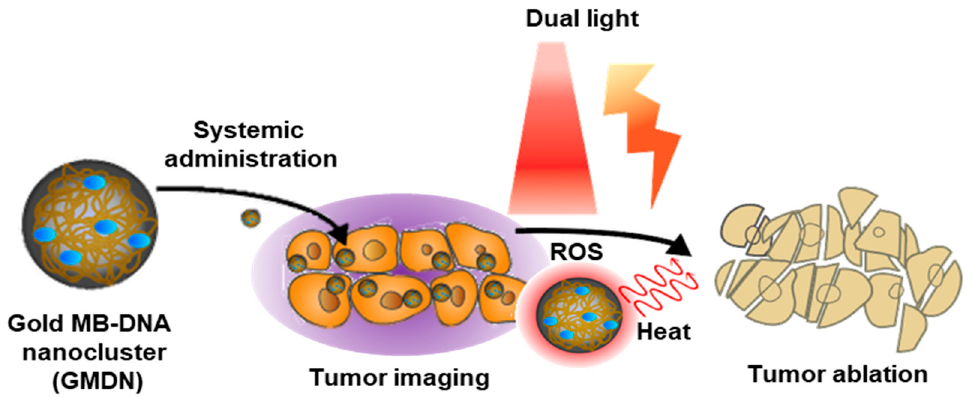
Figure 1. Schematic illustration. For synergistic dual phototherapy, methylene blue (MB) was trapped in gold DNA nanoclusters to form MB-trapped gold DNA nanoclusters (GMDN). After systemic administration, tumor accumulation of GMDN was monitored by molecular imaging. Then, dual light irradiation (660 nm and 808 nm) was applied to induce photodynamic and photothermal therapy for tumor ablation.